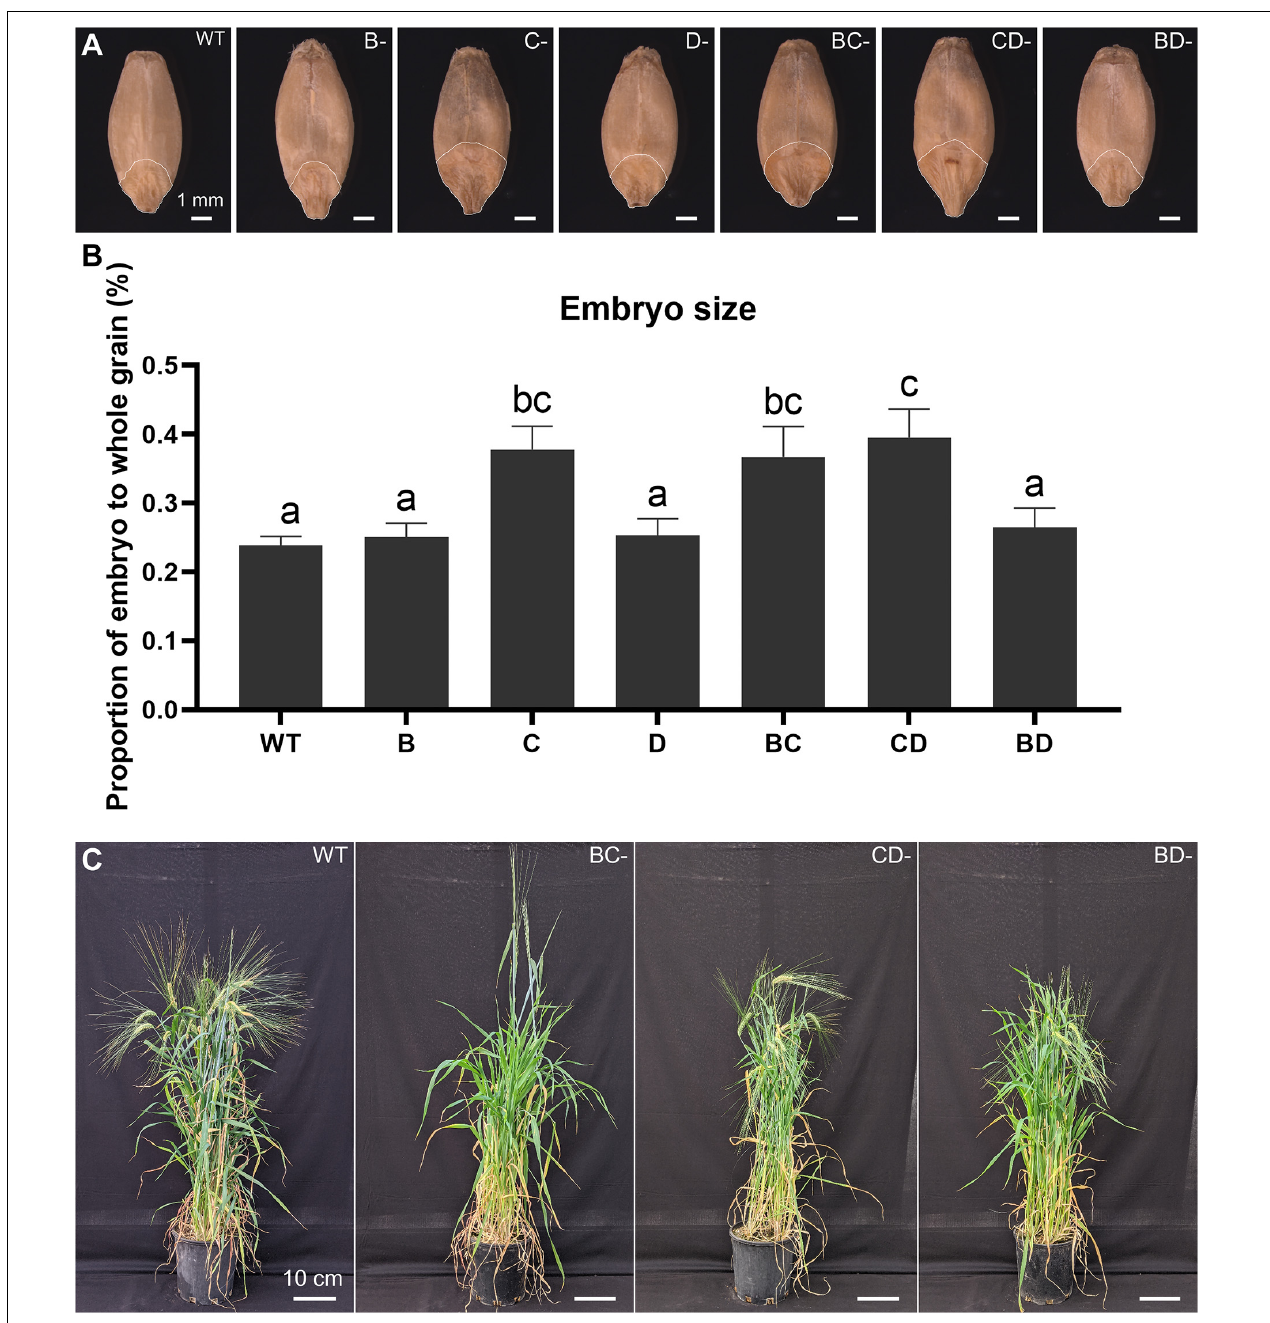
FIGURE 1 | Plant phenotypes and embryo size measurement across the WT, single- and double-mutant lines. (A) Grain morphologies of WT, B-, C-, D-hordein single-mutant lines and BC-, CD-, and BD-hordein double-mutant lines. The region on the grain outlined with a white line represents the embryo. Scale bar = 1 mm. (B) Embryo size comparison presented as mean ± standard deviation. Different letters indicate that the mean in each bar is significantly different ( p < 0.05) using ANOVA, Tukey’s HSD. (C) Plant morphologies of WT, BC-, CD-, and BD-hordein double-mutant lines. Scale bar = 10 cm.